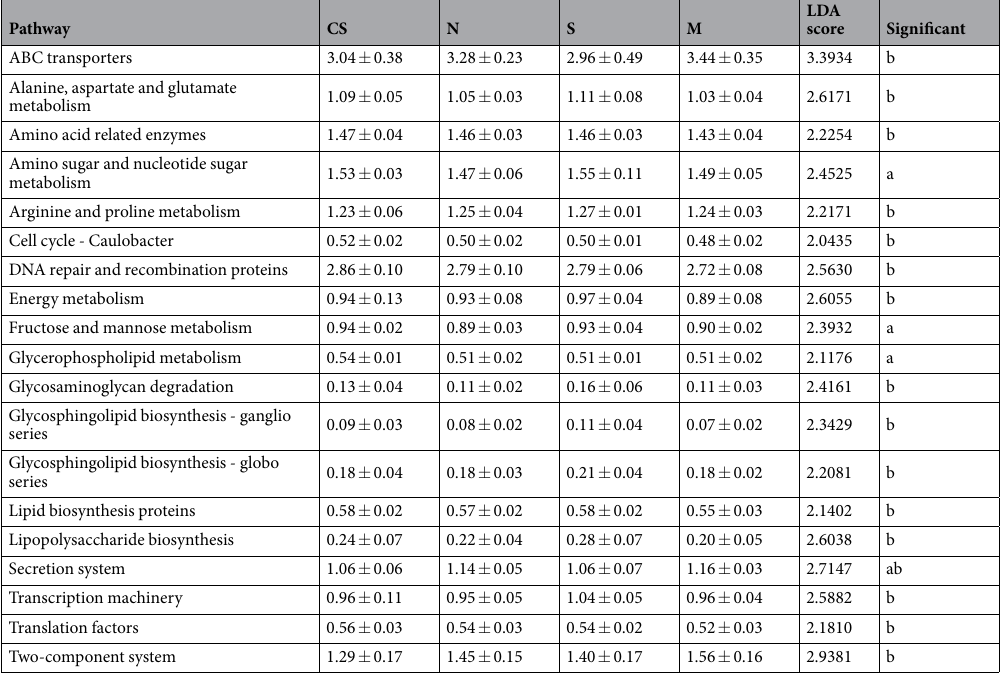
Table 4. Pathways significantly impacted by CS in mice. The numbers denote the relative abundance (mean ± SD). N: healthy mice + PBS; M: mice subjected to exhaustive exercise stress + PBS; CS: healthy mice supplemented with a daily dose of 150 mg/kg bodyweight of CS disaccharides for 16 days. S: the stressed mice supplemented with a daily dose of 150 mg/kg bodyweight of CS disaccharides for 16 days. Significant means that the abundance of the hits assigned to a given pathway that was changed at a cutoff value of the absolute log10 LDA scores > 2.0 between the two contrast groups using Linear Discriminant Analysis (LDA) Effect Size (LEfSe) algorithm (a = CS vs N; b = S vs M; c = M vs